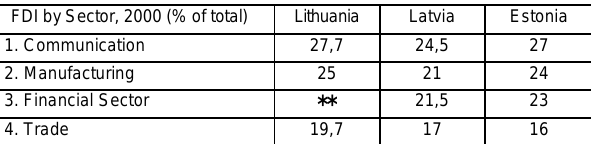
Table 3. Composition of FDI by sectors of economy FDI by Sector, 2000 (% of total) Lithuania Latvia Estonia 27,7 24,5 27